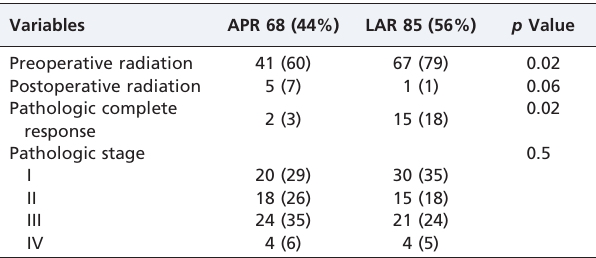
Table 2 - Radiation therapy and pathologic